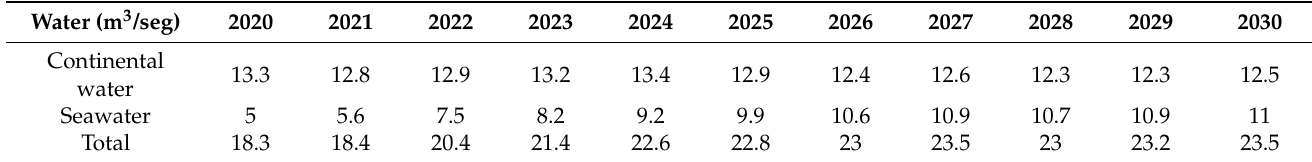
Table 1. Projection of expected water consumption in copper mining (Data from: